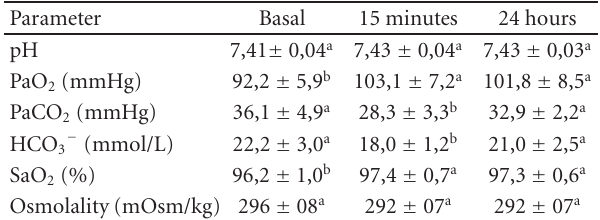
Table 2: Mean values ± standard deviations of arterial blood gas parameters and serum osmolality of dogs ( n = 10) before (Basal) and 15 minutes and 24 hours after induction of acute normovolemic